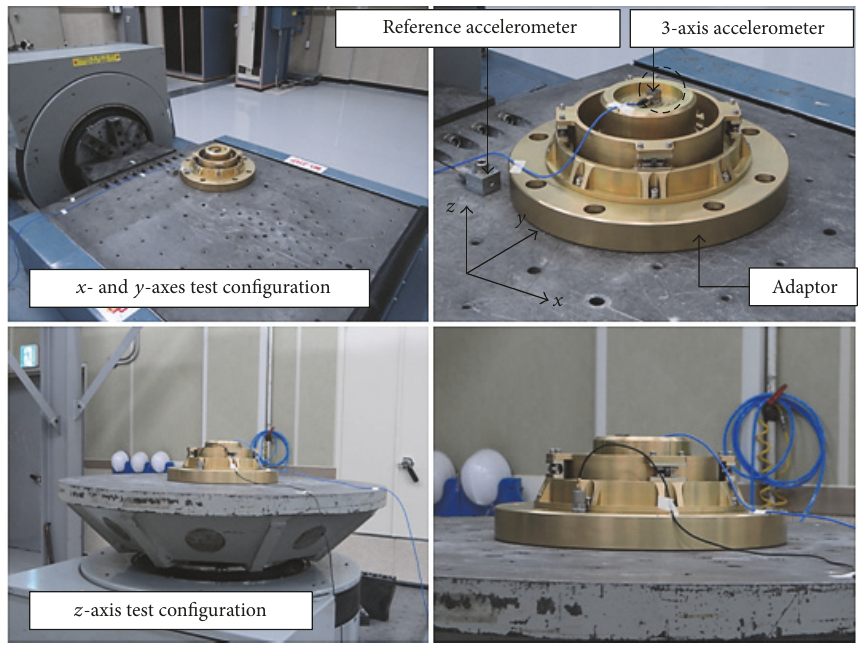
Figure 8: Configuration of the launch vibration